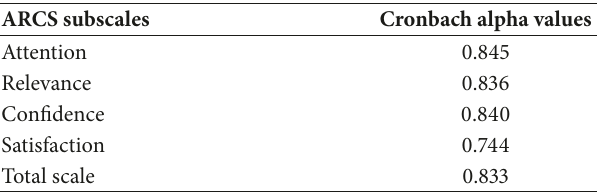
Table 3: Cronbach alpha